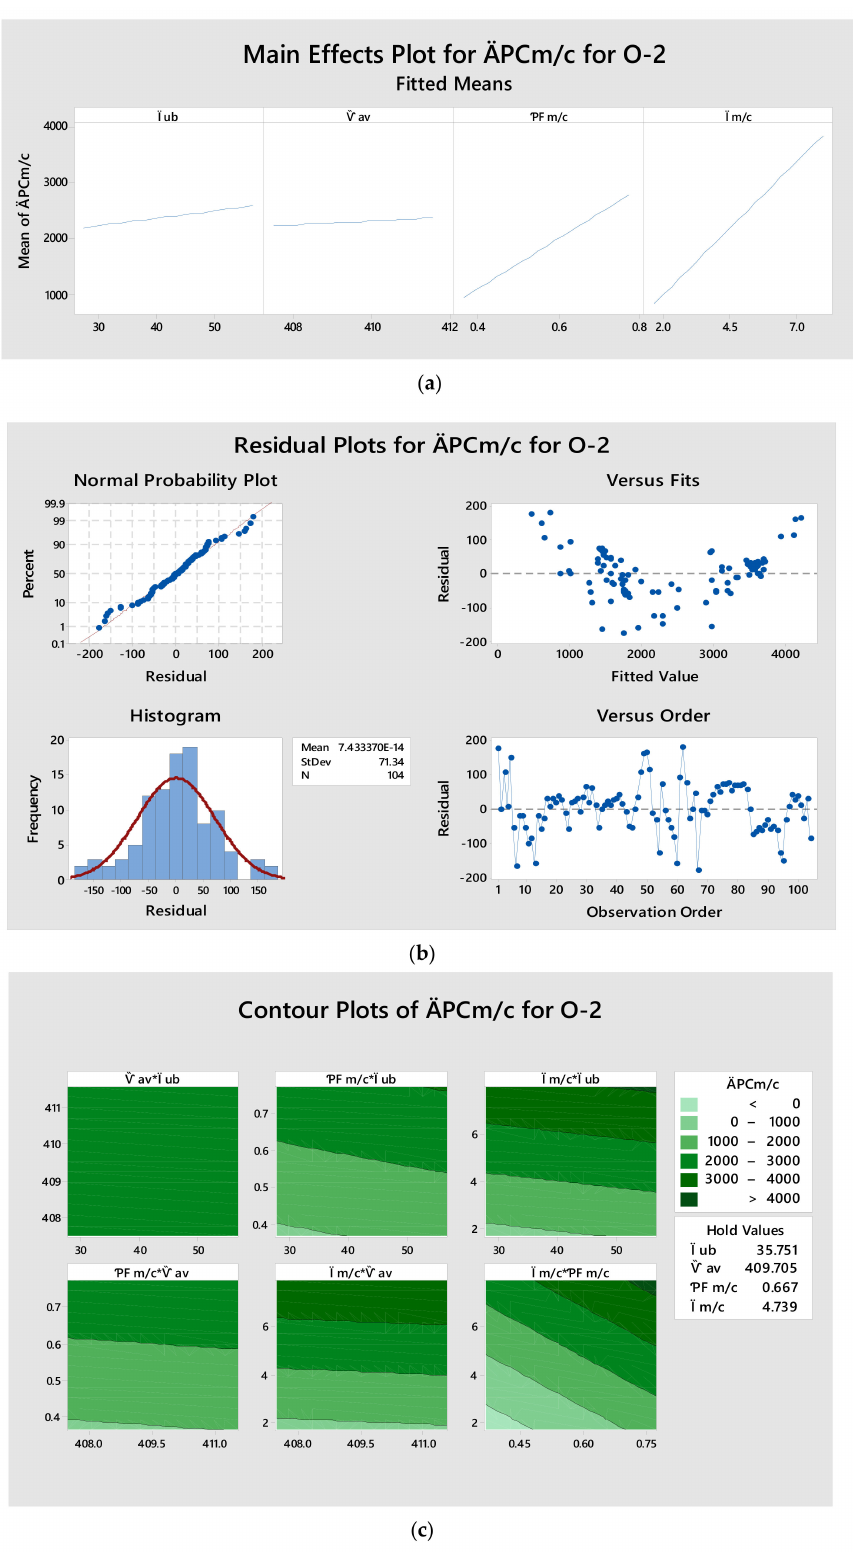
Figure 5. ( a ) Main effects plot for O-2. ( b ) Residuals plot for O-2. ( c ) Contour plots for